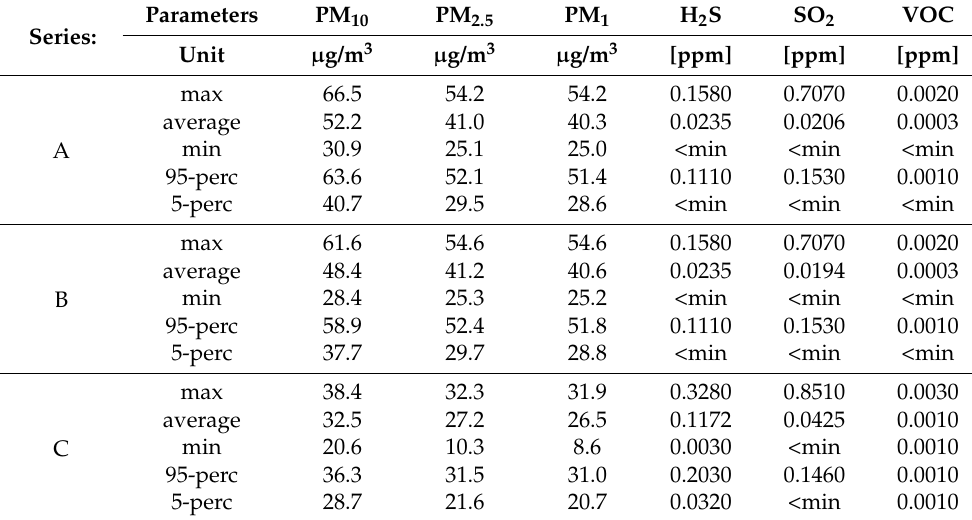
Table 3. Summary of measurement data for three series from the area of VIEP stations. Series: